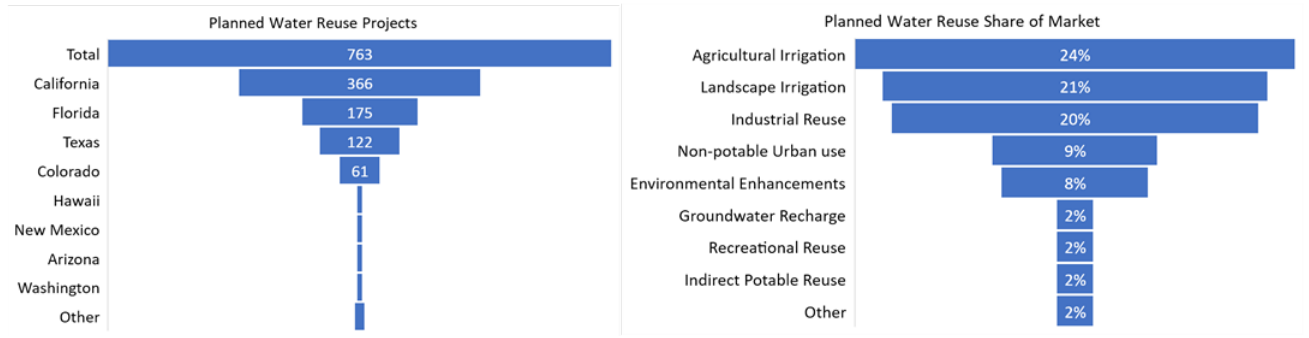
Figure 1. Planned water reuse projects by state and planned water reuse share of the market based on data collected by Blue Field Research [3].